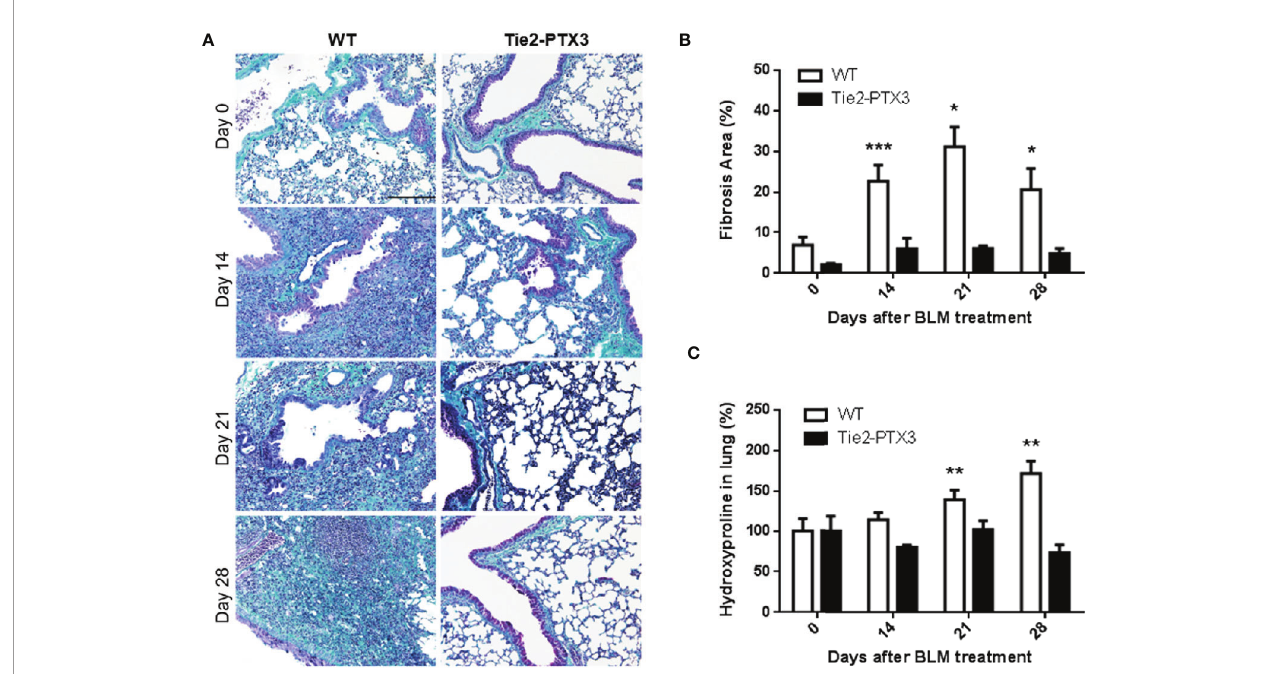
FIGURE 2 | Stromal PTX3 overexpression prevents lung fi brosis in BLM-treated mice. Fibrosis in lungs of wild type (WT) and transgenic Tie2-PTX3 mice treated with bleomycin (BLM) was determined by Masson ’ s trichrome staining (A) , subsequent quanti fi cation of fi brotic area (B) , and quanti fi cation of hydroxyproline in lungs extracts (C) . N = 5 – 8 mice/group; scale bar = 200 µm; *P < 0.05, **p < 0.01, ***p <